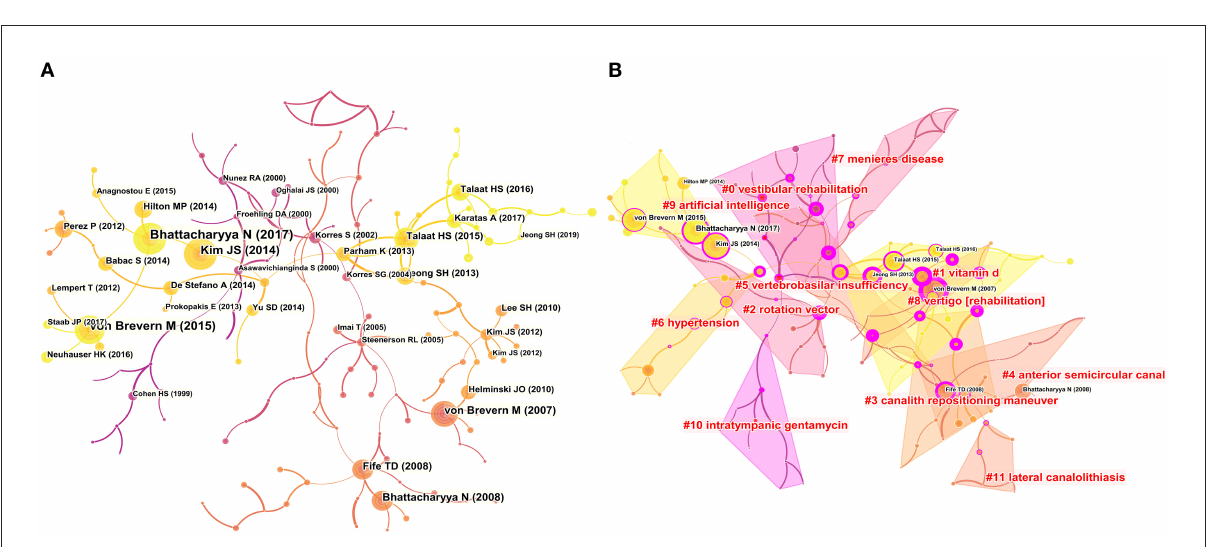
FIGURE6 (A) Map of co-cited references of publications related to BPPV. (B) Cluster analysis of networks with co-cited